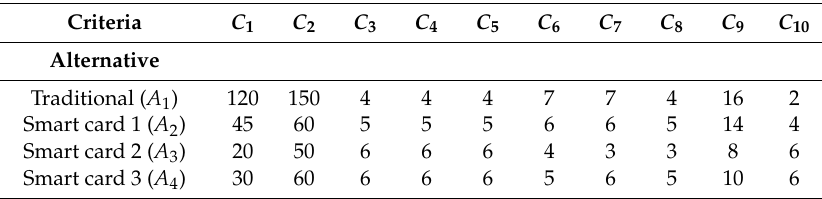
Table A1. Initial decision matrix filled by DM1 for WASPAS analysis.